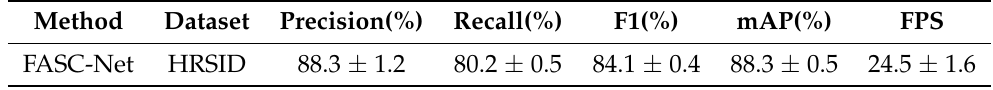
Table 5. Experimental results on the HRSID